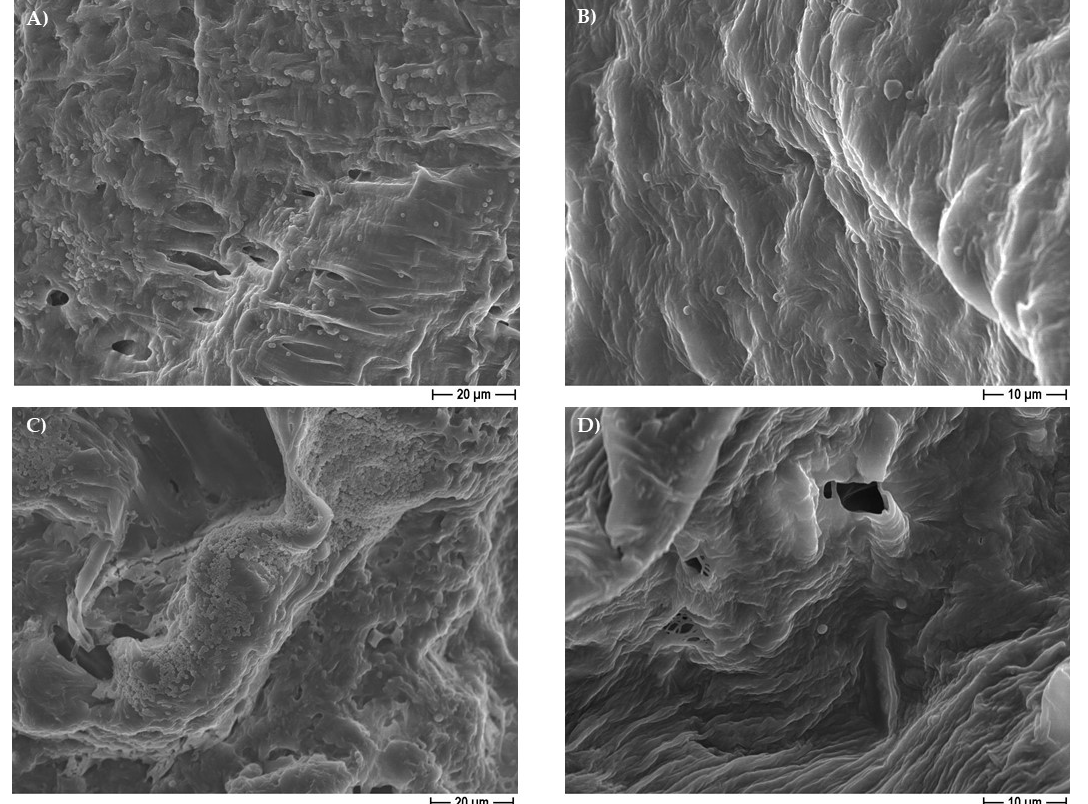
Figure 12. Representative FESEM micrographs regarding S. aureus presence on non-sonicated PCL- based scaffolds ( A ) and 30% cinnamon oil-added PCL-based scaffolds ( B ), or S. epidermidis presence on non-sonicated PCL-based scaffolds ( C ) and 30% cinnamon oil-added PCL-based scaffolds ( D ), obtained by using NaCl salt as a template, at 1000 × or 2000 × magnification, respectively.